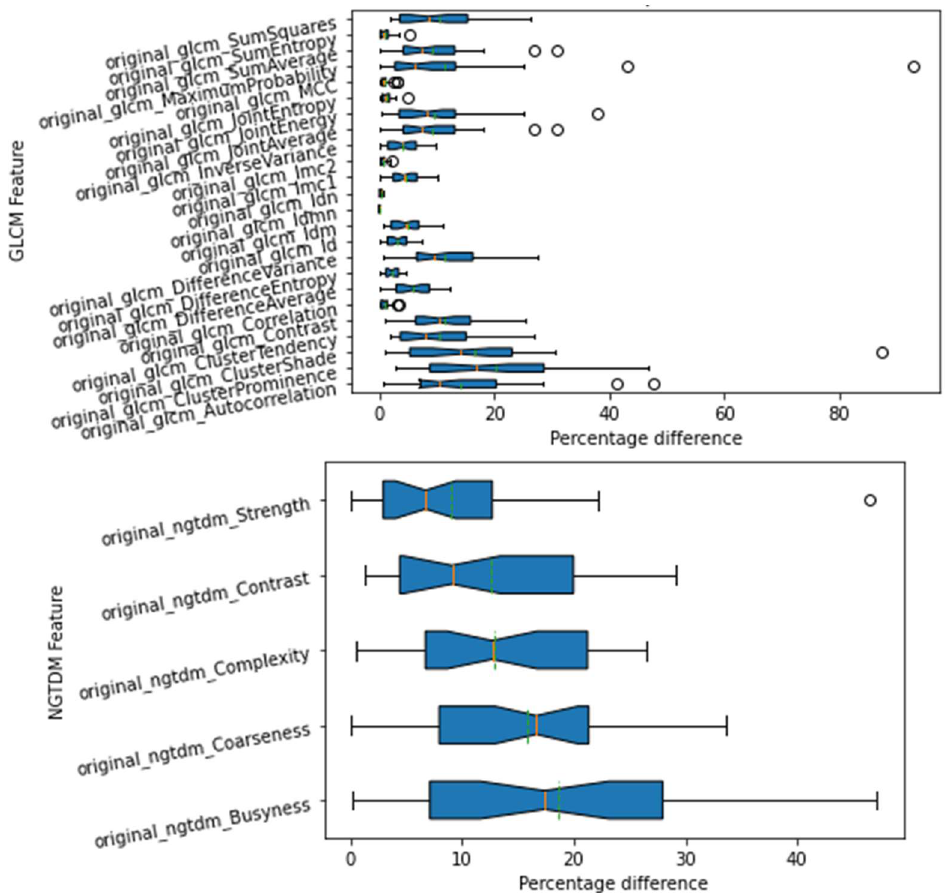
Figure 3. Difference percentage between non-co-registered and co-registered PET with T1-weighted and FLAIR MRI (the median is indicated in orange, while mean in green) for first-order, and GLCM, and NGTDM features, respectively.